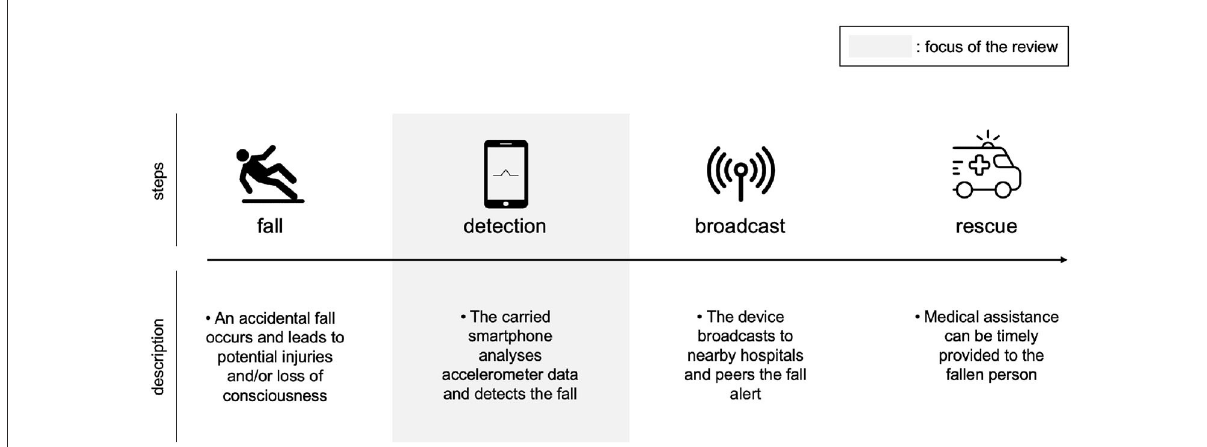
FIGURE1 Principle for fall detection with a smartphone, our review focuses on the detection